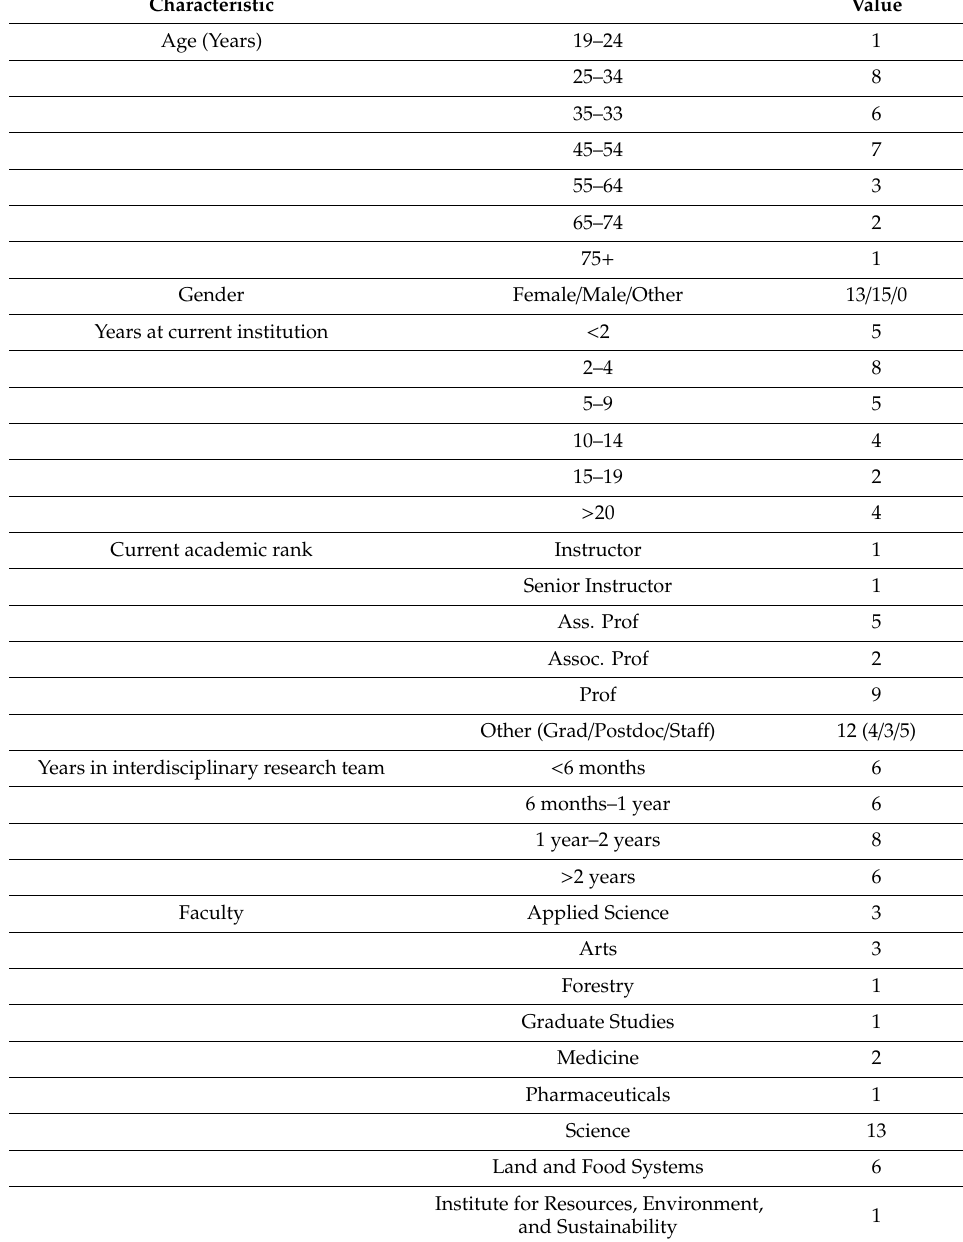
Table 1. Demographic characteristics of the participant